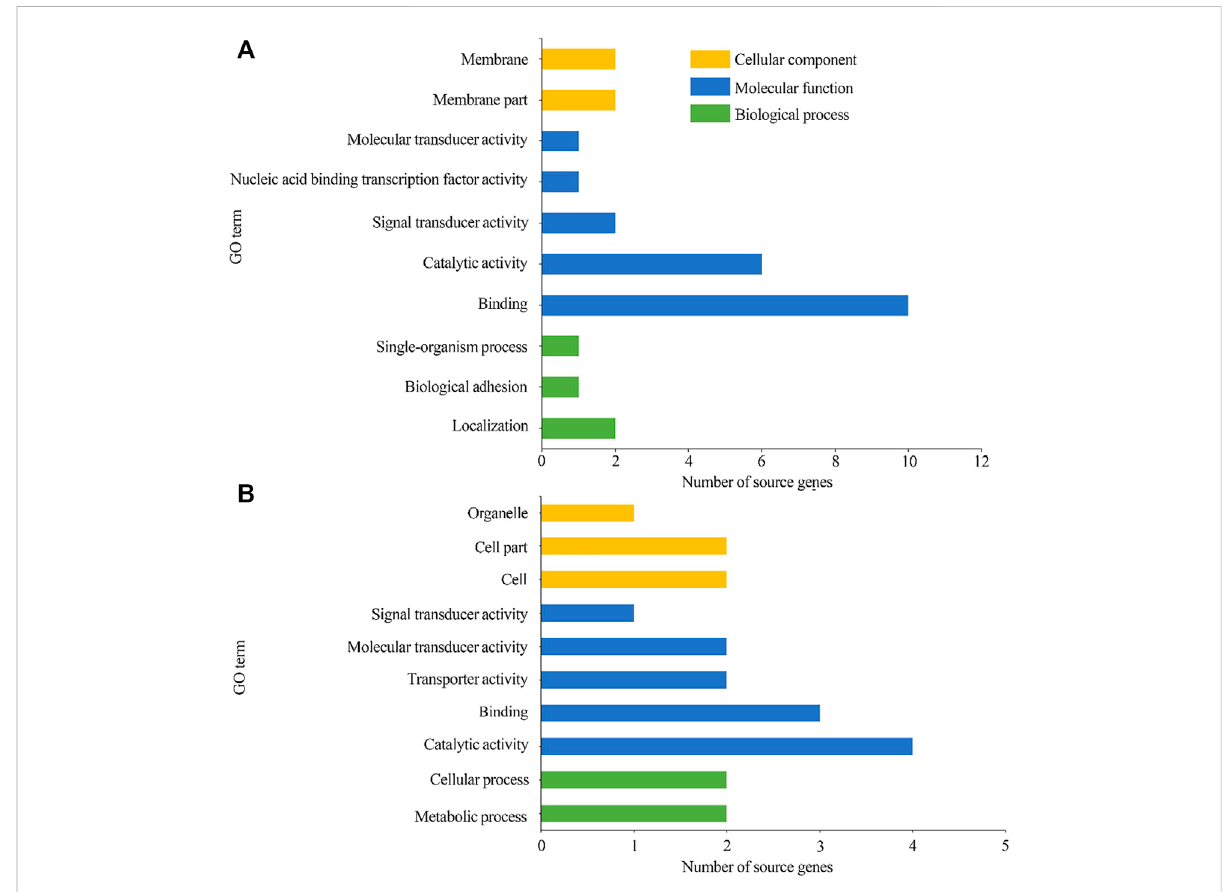
FIGURE 4 GO categorization of DEcircRNAs ’ source genes in AcCK1 vs AcT1 (A) and AcCK2 vs AcT2 (B) comparison groups.